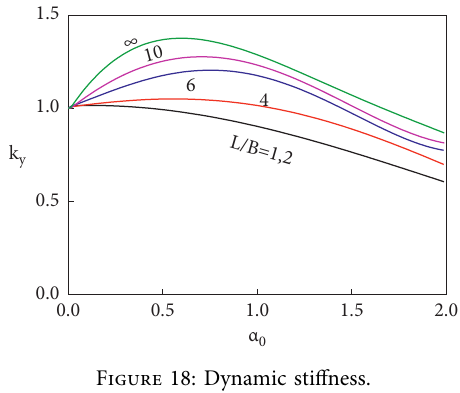
Figure 18: Dynamic stiffness.